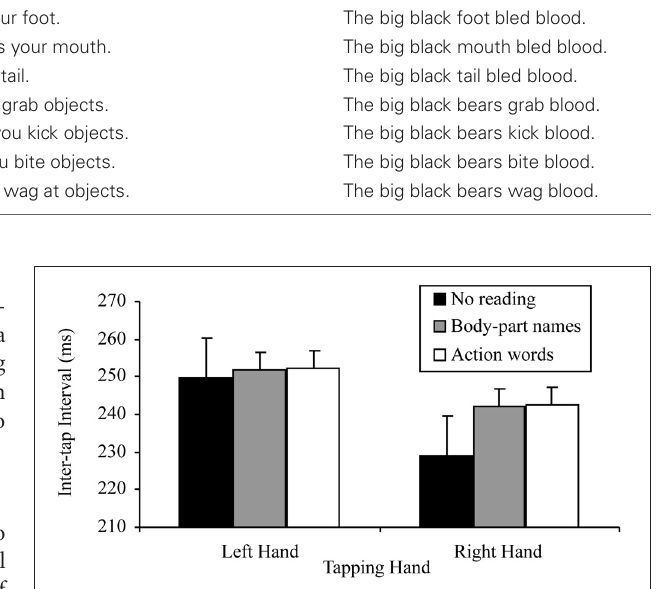
FIGURE 3 | Mean inter-tap intervals of each hand under the different reading conditions in the reading aloud data set (error bars represent one standard error of the